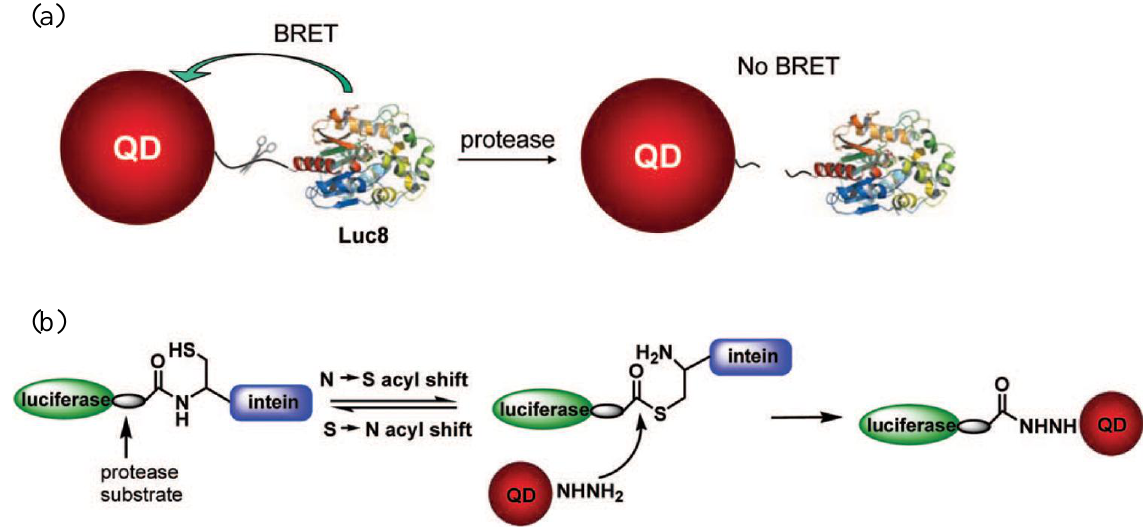
Figure 4. Schematic representation of QD BRET-based sensors for proteolytic activity of matrix metalloproteinases (MMPs): (a) QDs are linked to a bioluminescent mutant of Renilla luciferase protein (Luc8) through an MMP peptide substrate; (b) Intein, a polypeptide sequence able to excise itself and rejoin the remaining portions with a peptide bond, mediates site-specific conjugation of Luc8 fusion proteins to QDs through catalyzing the splicing reaction via formation of an active thioester intermediate (Reprinted with permission from [79], Copyright 2008 American Chemical